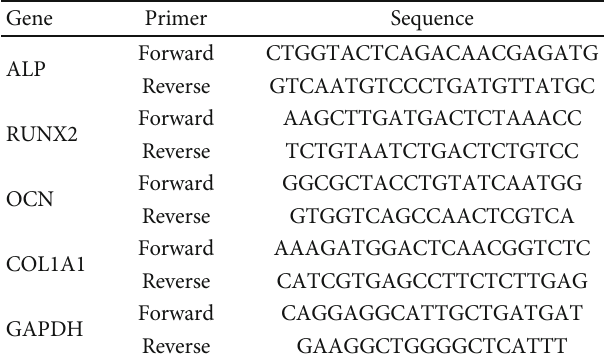
Table 1: Primers used in